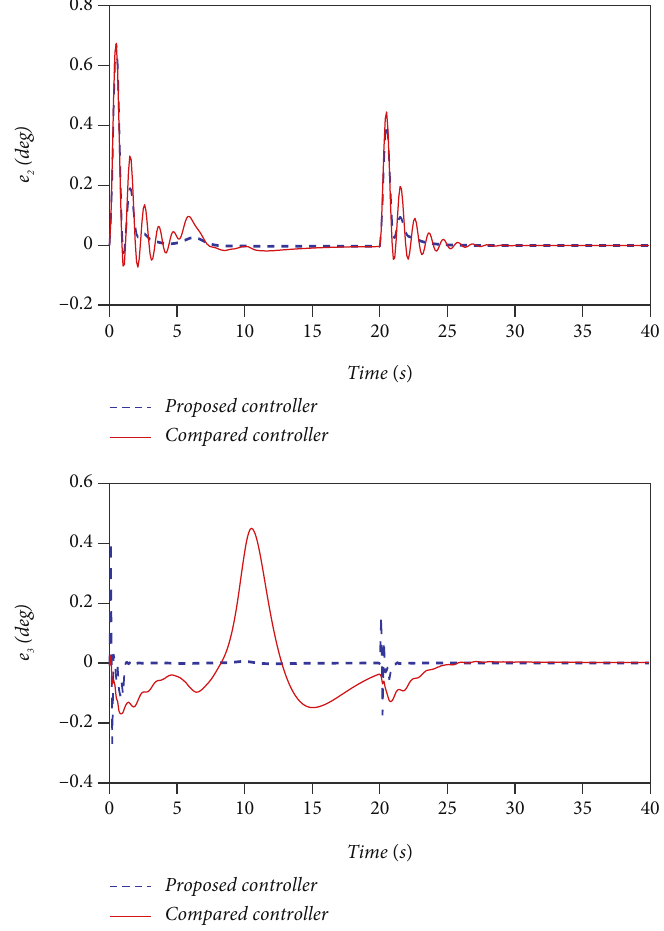
Figure 10: Tracking errors e